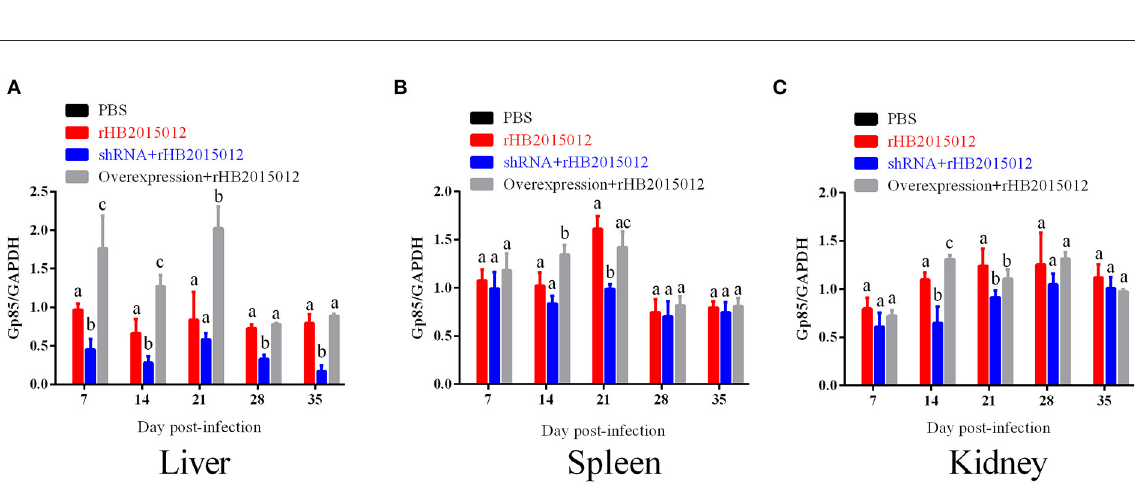
were found in the liver but not in the spleen or kidney (Figure